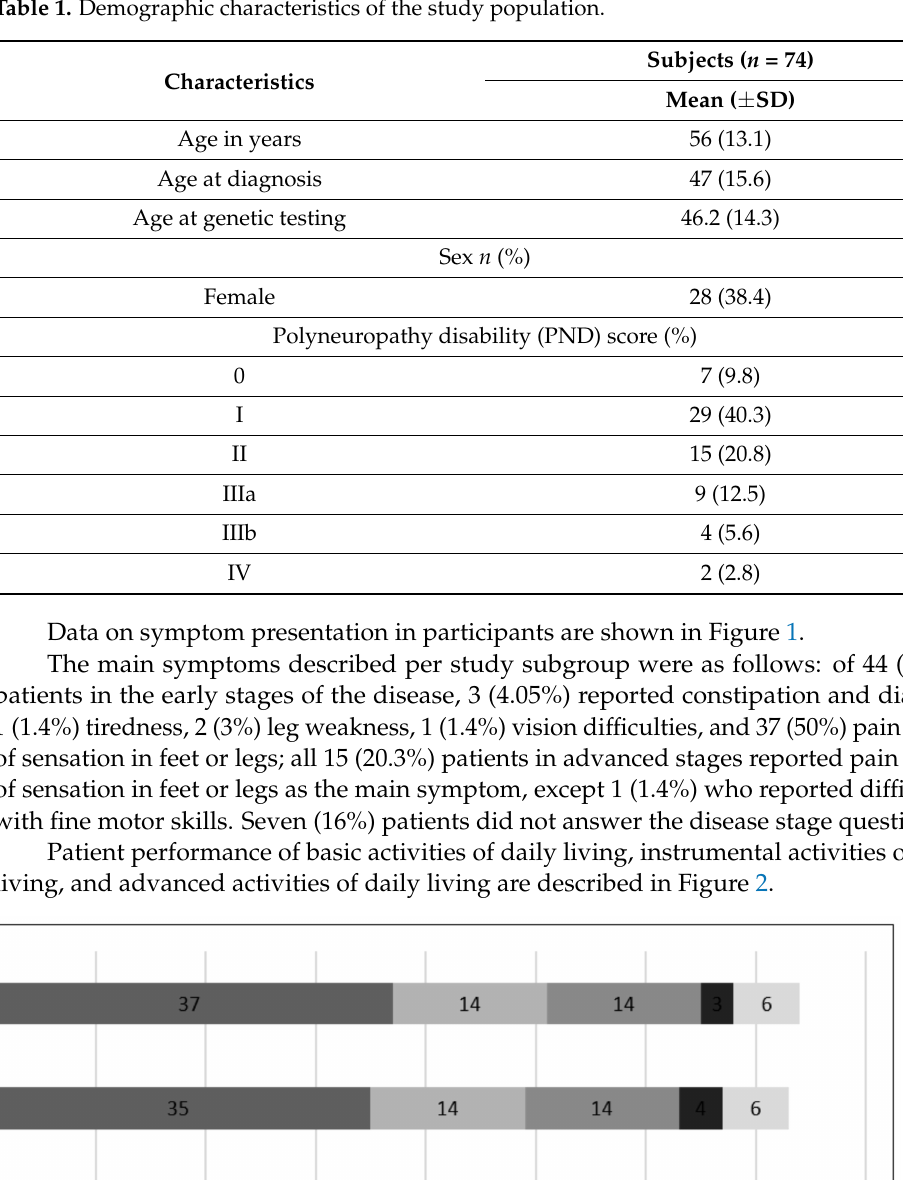
Table 1. Demographic characteristics of the study population.